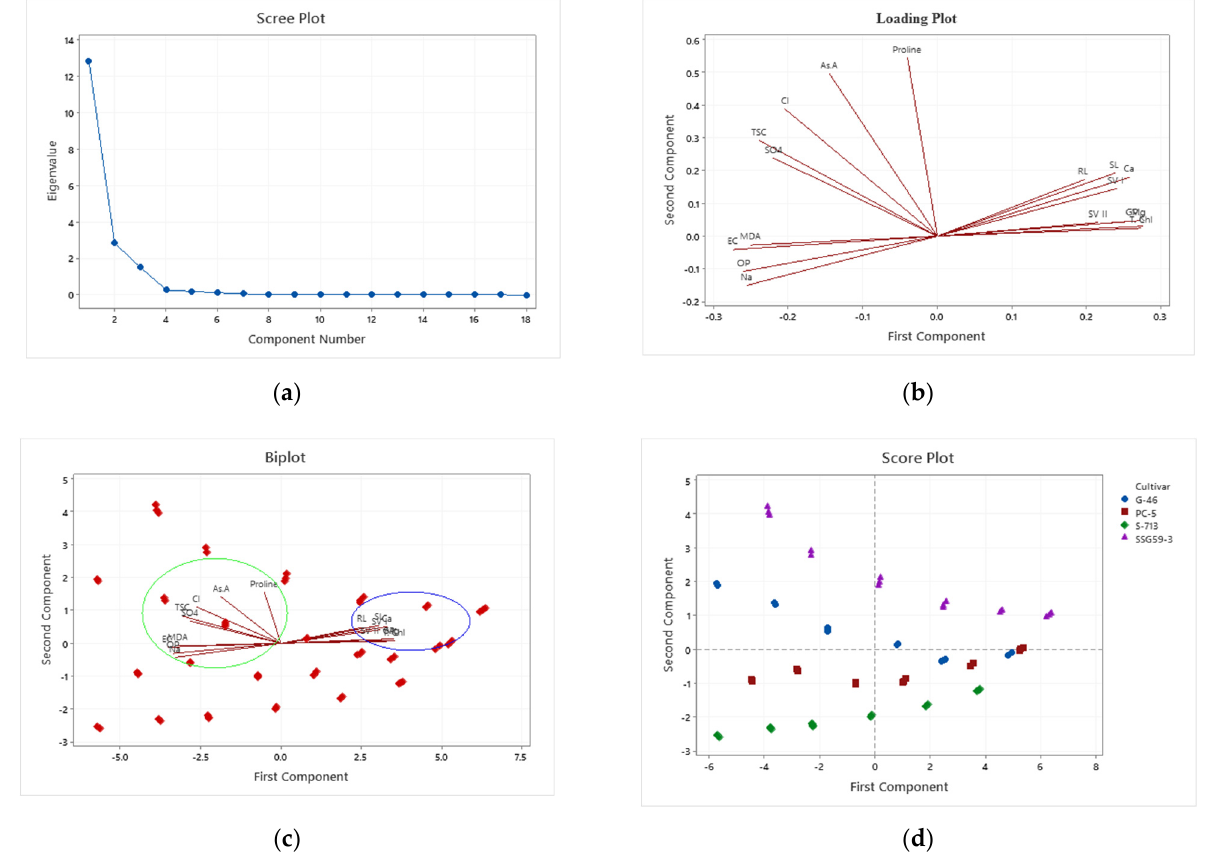
Figure 9. Plots of principal components of four sorghum lines. ( a ) scree plot; ( b ) loading plot; ( c ) biplot; ( d ) score plot.